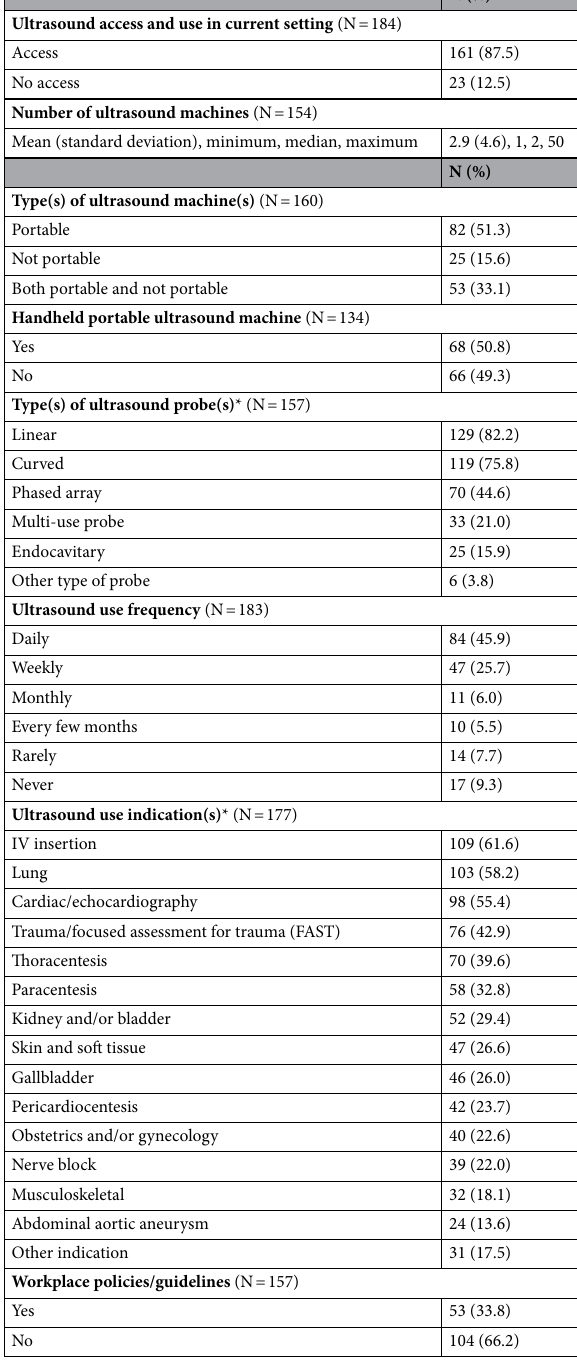
Table 3. Ultrasound access and use in low- and middle-income countries. *Total percentage for individual question may be over 100% due to “Check all that apply” option for that question on the survey. The value for N provided for “Check all that apply” questions represents the number of